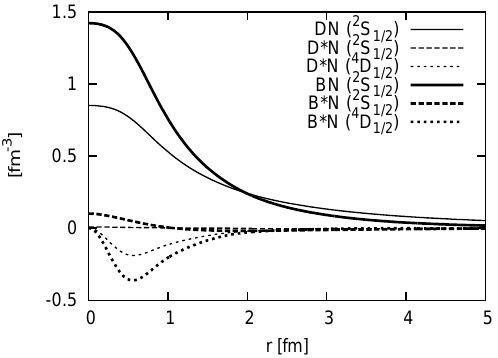
Fig. 1. The wave functions of the ¯ DN and BN bound states for J P = 1 / 2 − with I =